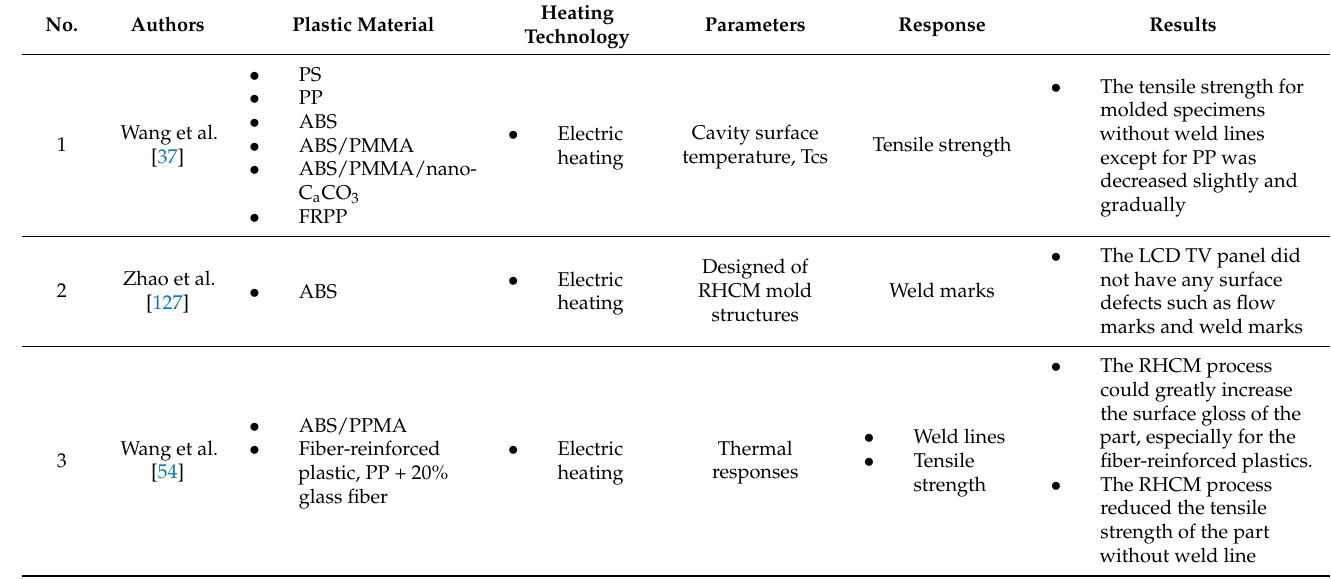
Table 7. Research on improved weld line strength performance and surface quality using